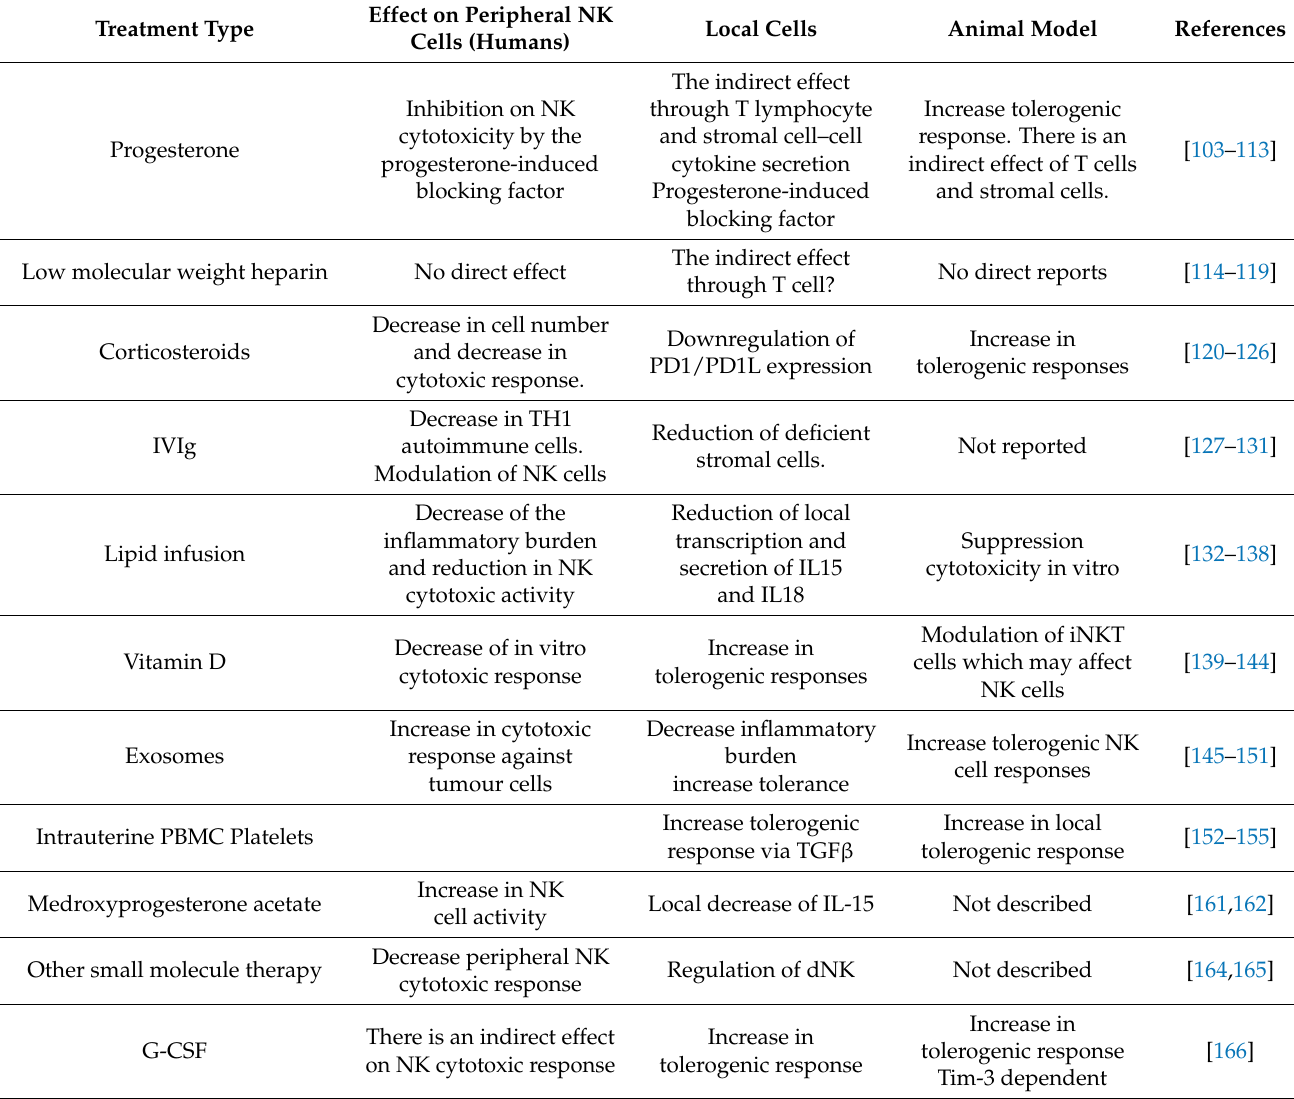
Table 2. Pharmacologic modulation of NK cells. The table represents the significant finding with the different described treatment for modulation of NK cell populations and